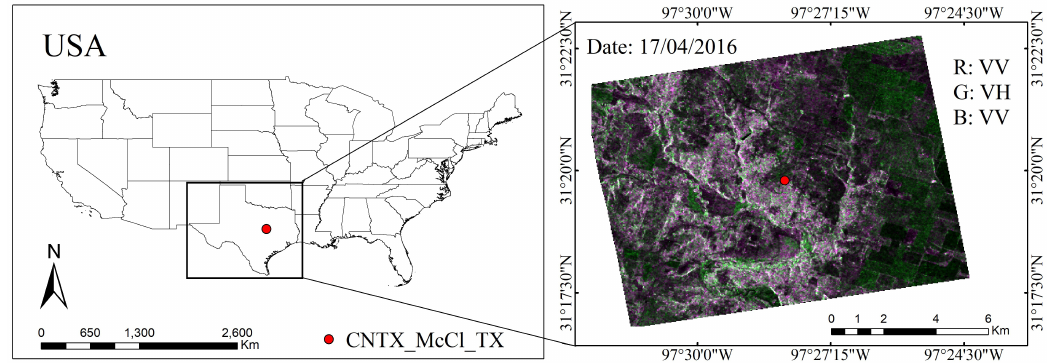
Figure 2. Geographical location of the selected field forest FMC measurement site. The background is a pseudo-color composited Sentinel-1A image (VV, VH and VV corresponding to R, G and B) on April 17, 2016.